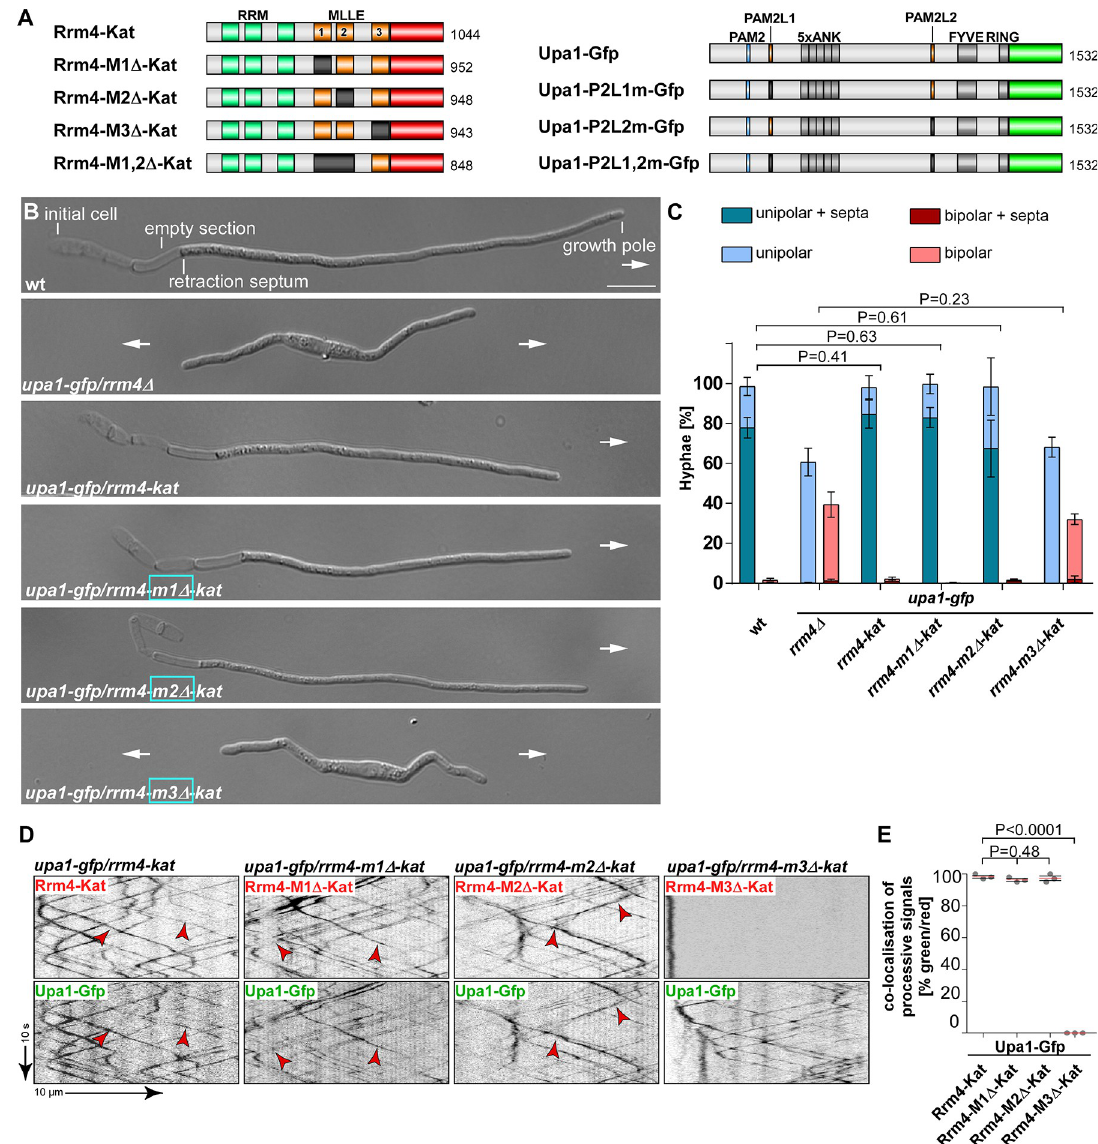
Fig 4. MLLE3 is key for endosomal mRNA transport. ( A ) Schematic representation of Rrm4 and Upa1 variants drawn not to scale (number of amino acids indicated next to protein bars) using the following colouring: dark green, RNA recognition motif (RRM); orange, MLLE domains; red, mKate2, blue, PAM2, light orange PAM2 like sequence (PL1–2) and light green, Gfp. Ankyrin repeats (5xANK), FYVE domain and RING domain of Upa1 are given in dark grey. ( B ) Growth of AB33 derivatives in their hyphal form (6 h.p. i.; size bar 10 μ m). Growth direction is marked by arrows. ( C ) Quantification of hyphal growth of AB33 derivatives shown in B (6 h.p.i.): unipolarity, bipolarity and basal septum formation were quantified (error bars, SEM.; n = 3 independent experiments, > 100 hyphae were counted per strain; for statistical evaluation, the percentage of uni- and bipolarity was investigated by using unpaired two-tailed Student’s t-test ( α < 0.05). ( D ) Kymographs of AB33 hyphae derivatives (6 h.p.i.; inverted fluorescence images) expressing pairs of red and green fluorescent proteins as indicated. Fluorescence signals were detected simultaneously using dual-view technology (arrow length on the left and bottom indicates time and distance, respectively). Processive co-localising signals are marked by red arrowheads. ( E ) Percentage of processive signals exhibiting co-localisation for strains shown in D (data points represent means from n = 3 independent experiments, with mean of means, red line and SEM; unpaired two-tailed Student’s t-test ( α < 0.05); for each experiment, 10 hyphae per strains were